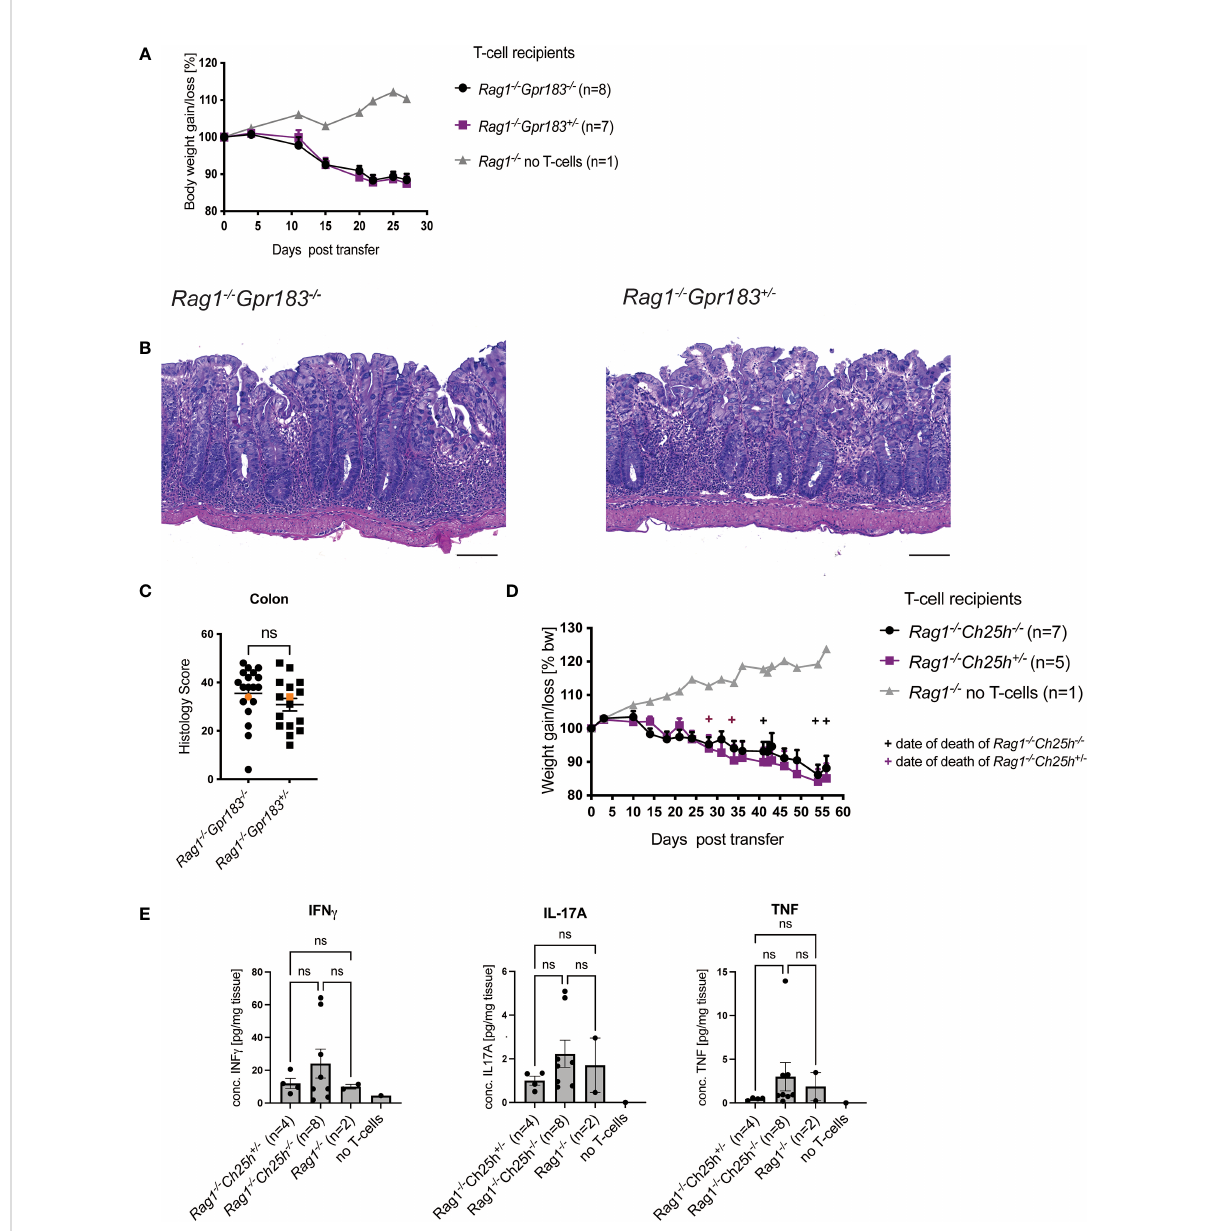
FIGURE 2 Expression of GPR183 or CH25H in Rag-/- mice are not required for colitis. Colitis was induced by adoptive transfer of naive CD4 + T cells from wildtype C57BL/6 mice into GPR183 de fi cient ( Gpr183 -/- ) vs. littermate control ( Gpr183 +/- ) Rag1 -/- recipients. (A) Weight change was monitored as % starting body weight on the indicated days. A representative weight graph from one of 3 independent experiments is shown. (B) H&E staining of representative colon sections (middle part of whole colon) at 40x (scale bar 100 m m) magni fi cation. (C) Blinded histology score from the middle part of whole colon combined from 3 independent experiments. Representative images in B) were taken from mice represented by the orange colored data points. (D) Colitis was induced by adoptive transfer of naive CD4 + T cells from wildtype C57BL/6 mice into CH25H de fi cient ( Ch25h -/- ) vs. control ( Ch25h +/- ) Rag1 -/- recipients. Disease progression was monitored by assessing weight loss. A representative weight graph from one of 3 independent experiments is shown. The weight of dead mice was carried forward, indicated with + signs in magenta for control mice and in black for Rag1 -/- Ch25h -/- mice. (E) Colon explant cytokine quanti fi cation from distal colon at the end of T-cell transfer model. Cytokines were measured by CBA; two independent experiments were pooled. Error bars represent S.E.M. Two-way ANOVA (Tukey ’ s test) (A and D) and nonparametric T-test (Mann-Whitney test) (C) and One-way ANOVA (Tukey ’ s test) (E) . ns, not signi fi